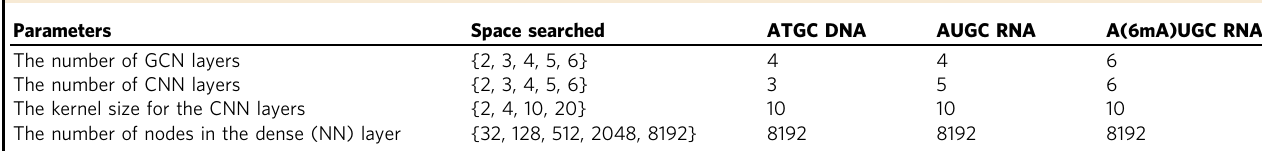
Table 3 Hyperparameters searched in the